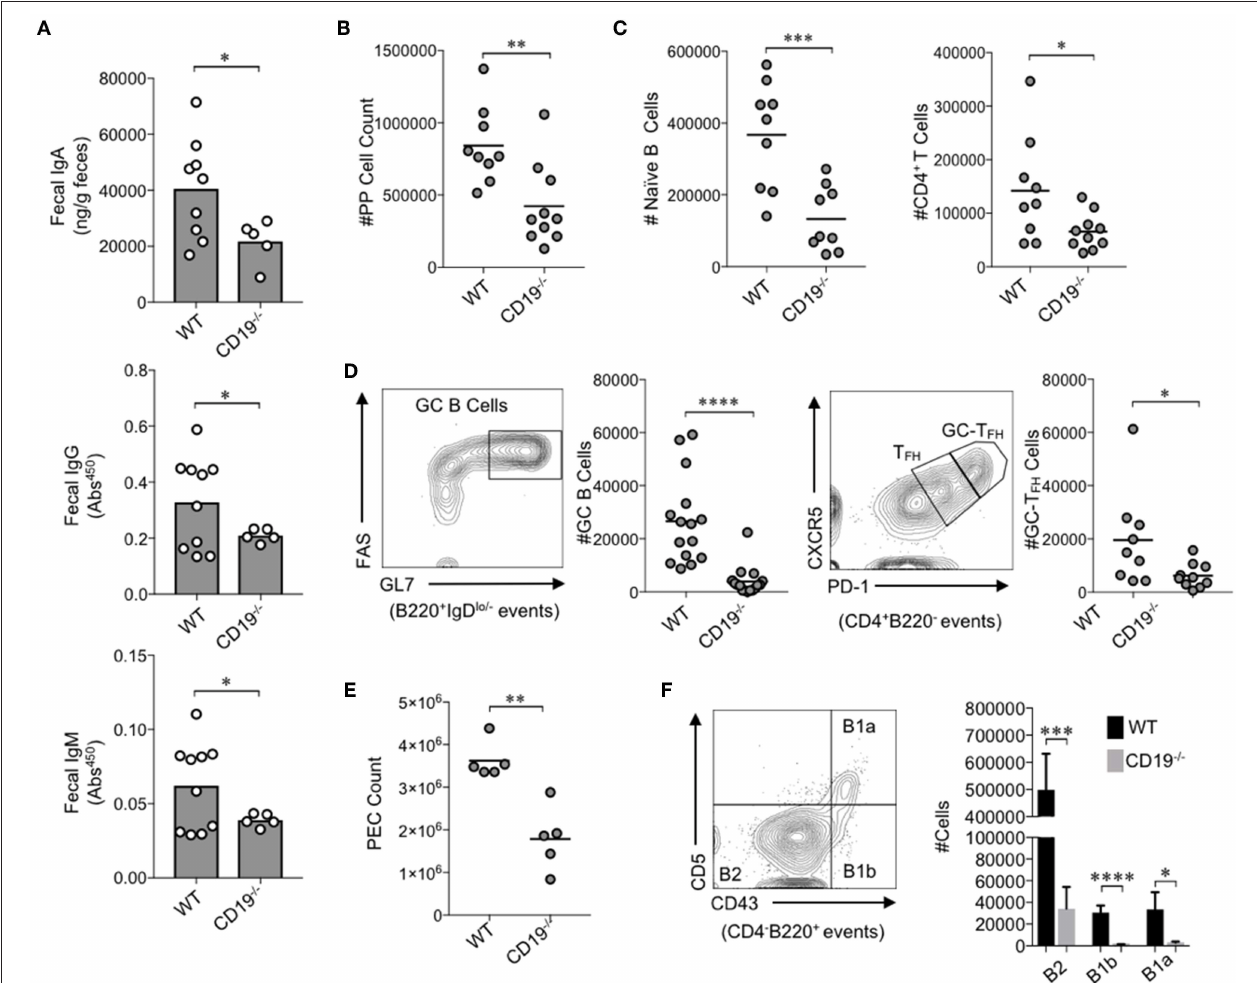
FIGURE 1 | CD19 − / − mice develop gut mucosal antibody deficiency due to defects in B cell development in gut-associated lymphoid tissues. (A) The fecal concentrations of IgA, IgG, and IgM are shown. (B) The total number of lymphocytes isolated from PPs of mice is shown. (C) The total number of naïve B cells and CD4 + T cells in PPs is shown. (D) A representative flow plot demonstrating gating on GC B cells and GC-T FH cells is provided and the total abundance of GC B cells and GC-T FH cells is shown. (E) The total number of peritoneal lavage cells is shown. (F) A representative flow plot demonstrating gating on peritoneal B cell subsets is provided and the total abundance of B2, B1a, and B1b cells is shown. (A–F) Student’s t -test (* = p < 0.05, ** = p < 0.01, *** = p < 0.001, **** = p < 0.00001). See Supplementary Figure S2 for details on gating